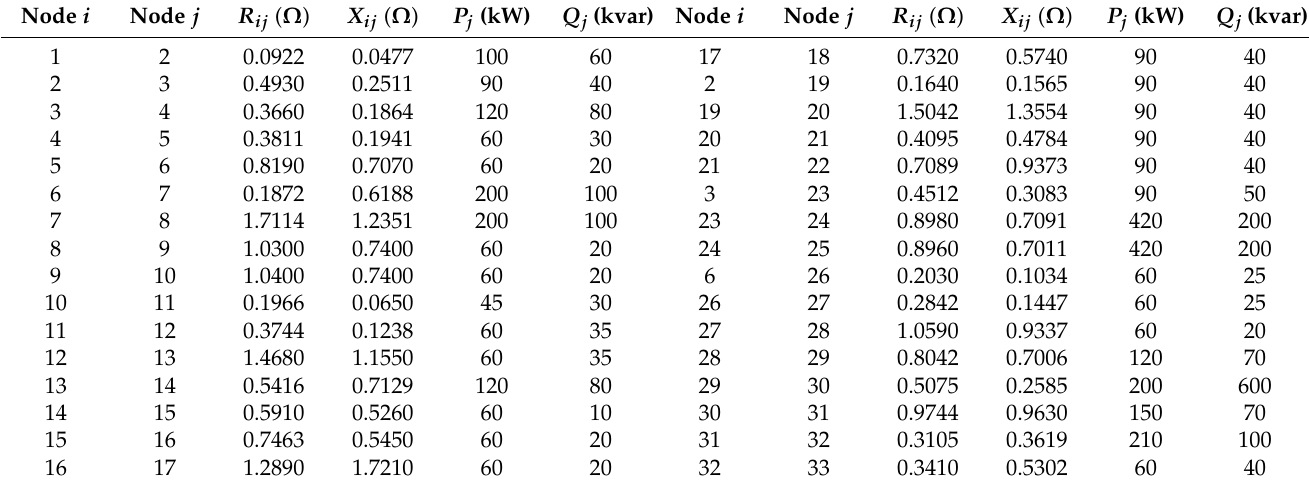
Table 2. Parametric information of the IEEE 33-bus grid regarding loads and distribution lines.